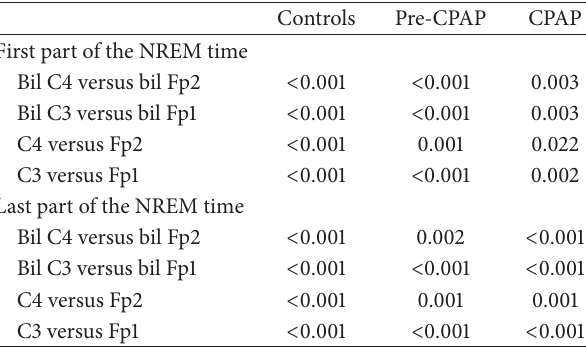
Table 4: 𝑝 values of the comparisons between the central and frontopolar spindle frequencies in the different study groups.